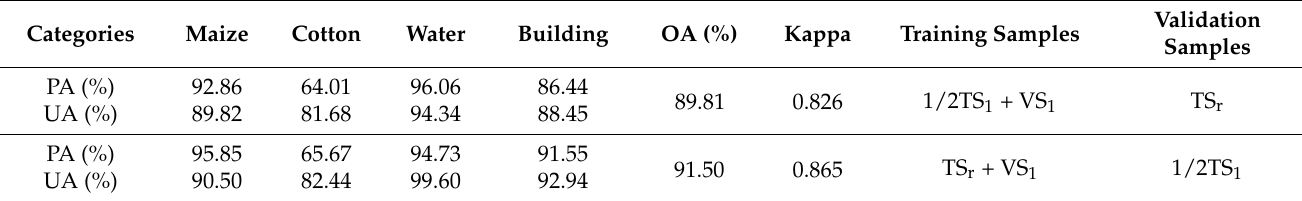
Table 10. Accuracies and Kappa coefficients of the classification of four land-cover types using 11 features and different training and validation samples. (TS 1 , TS r and VS 1 denotes the same meaning as in Table 8).